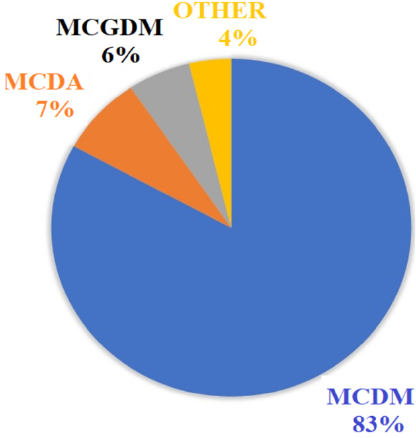
Figure 1. Sustainable transport articles using fuzzy-based decision techniques for the period 2000–2022.